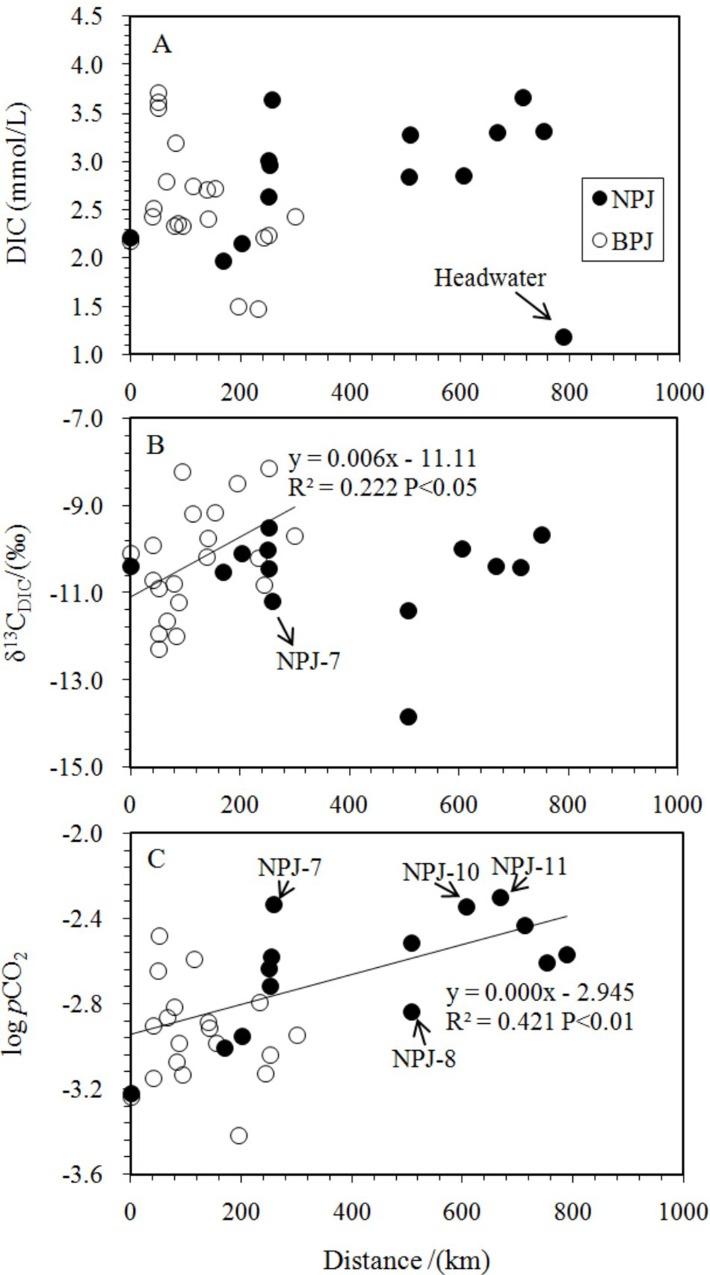
Spatial distribution in DIC (a), δ13CDIC (b), and logpCO2(c) along the studied rivers; NPJ: Nanpan River samples, BPJ: Beipan River samples. Distance refers to distance to the outlet of the basin (S1 Table). The legends in the following figures are the same to the Fig 2.